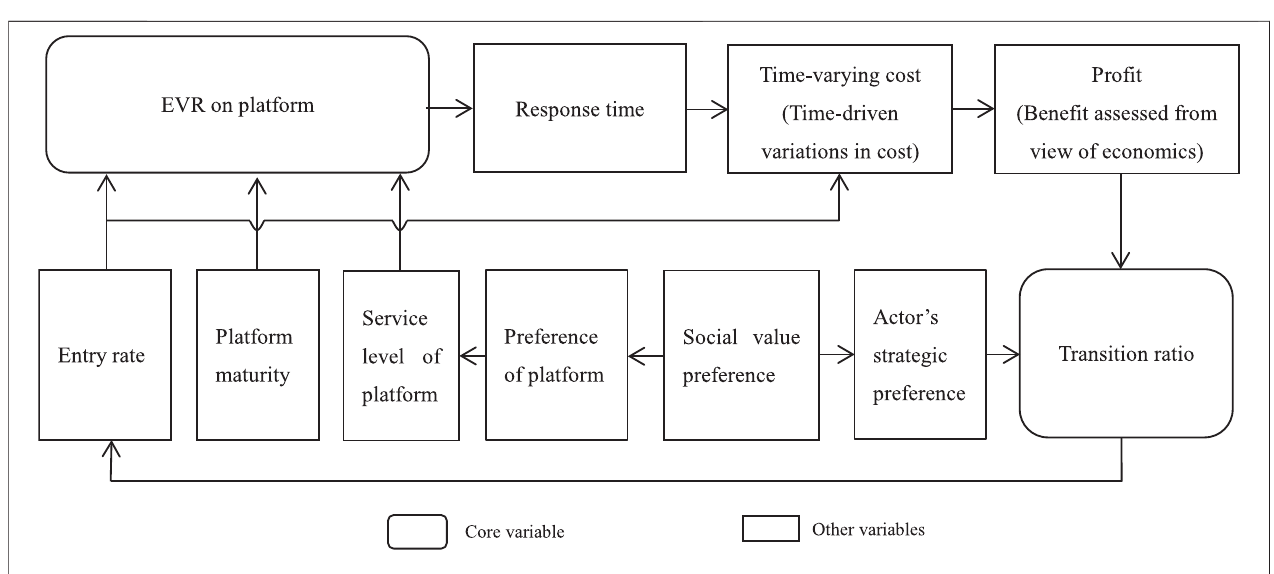
FIGURE 3 | Model illustrating the mechanism between EVR and transition ratio.